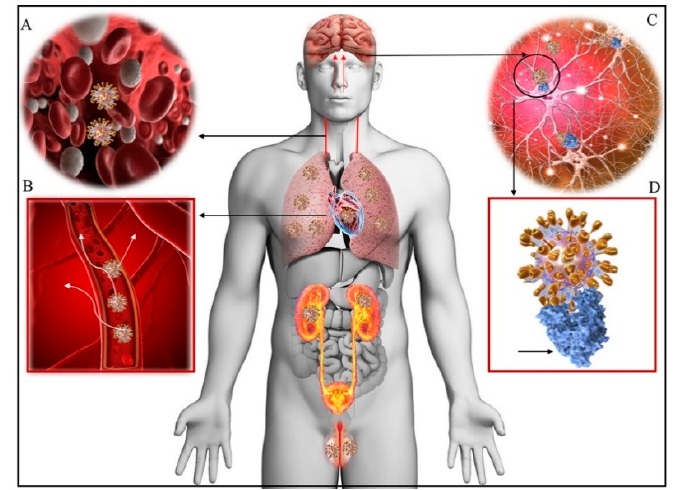
Figure 3. SARS-CoV-2 distribution in human body. A —Viremia: SARS-SoV-2 virus dissemination throughout the body via the bloodstream. B —Neurotropism via circulation and/or an upper nasal transcribrial route that enables the COVID-19 to modify the function of the blood–brain barrier or directly reach the brain. C —Virus binding and engaging with the ACE2 receptors. D —SARS-CoV-2 docks on the ACE2 via spike protein (blue); major organs – lungs, heart, kidneys, intestines, brain, and testicles, that express ACE2 receptors and are possible targets of COVID-19 (D, golden spikes) [45] .